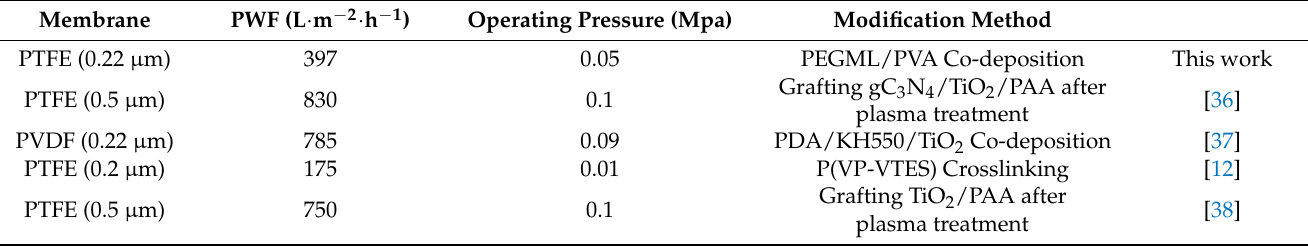
Figure 9. ( a ) Dynamic contact angle of different PTFE microfiltration membranes; ( b ) water flux of different PTFE microfiltration membranes (the test pressure is 0.05 Mpa). Table 4. Comparison of hydrophilic modification methods of various microfiltration membranes.